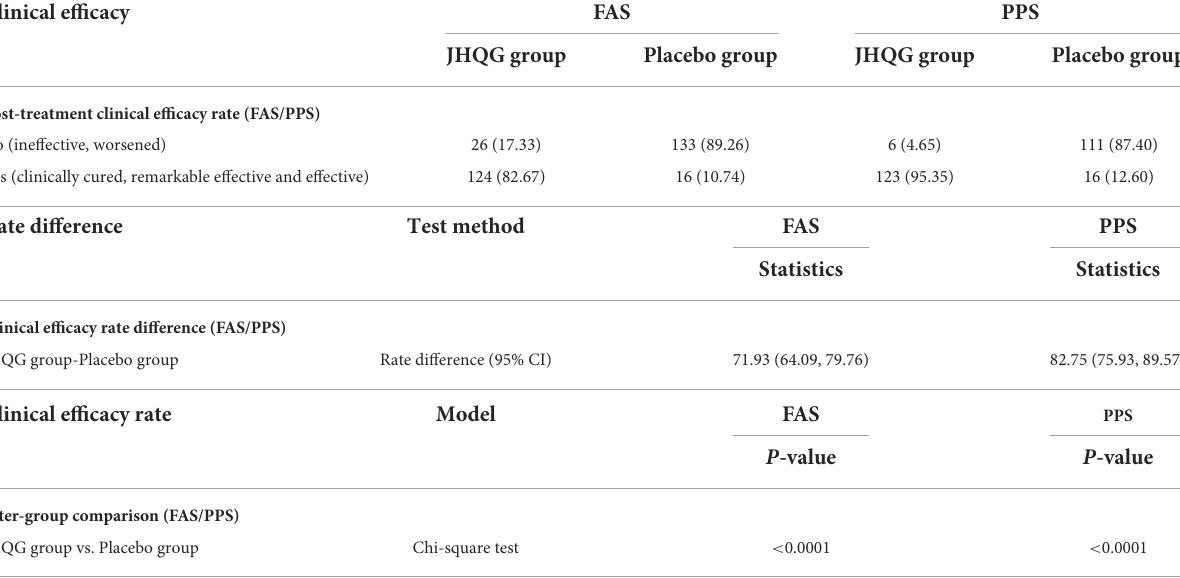
TABLE 3 Post-treatment clinical efficacy rate (FAS/PPS), rate difference (FAS/PPS), and inter-group comparison. Clinical